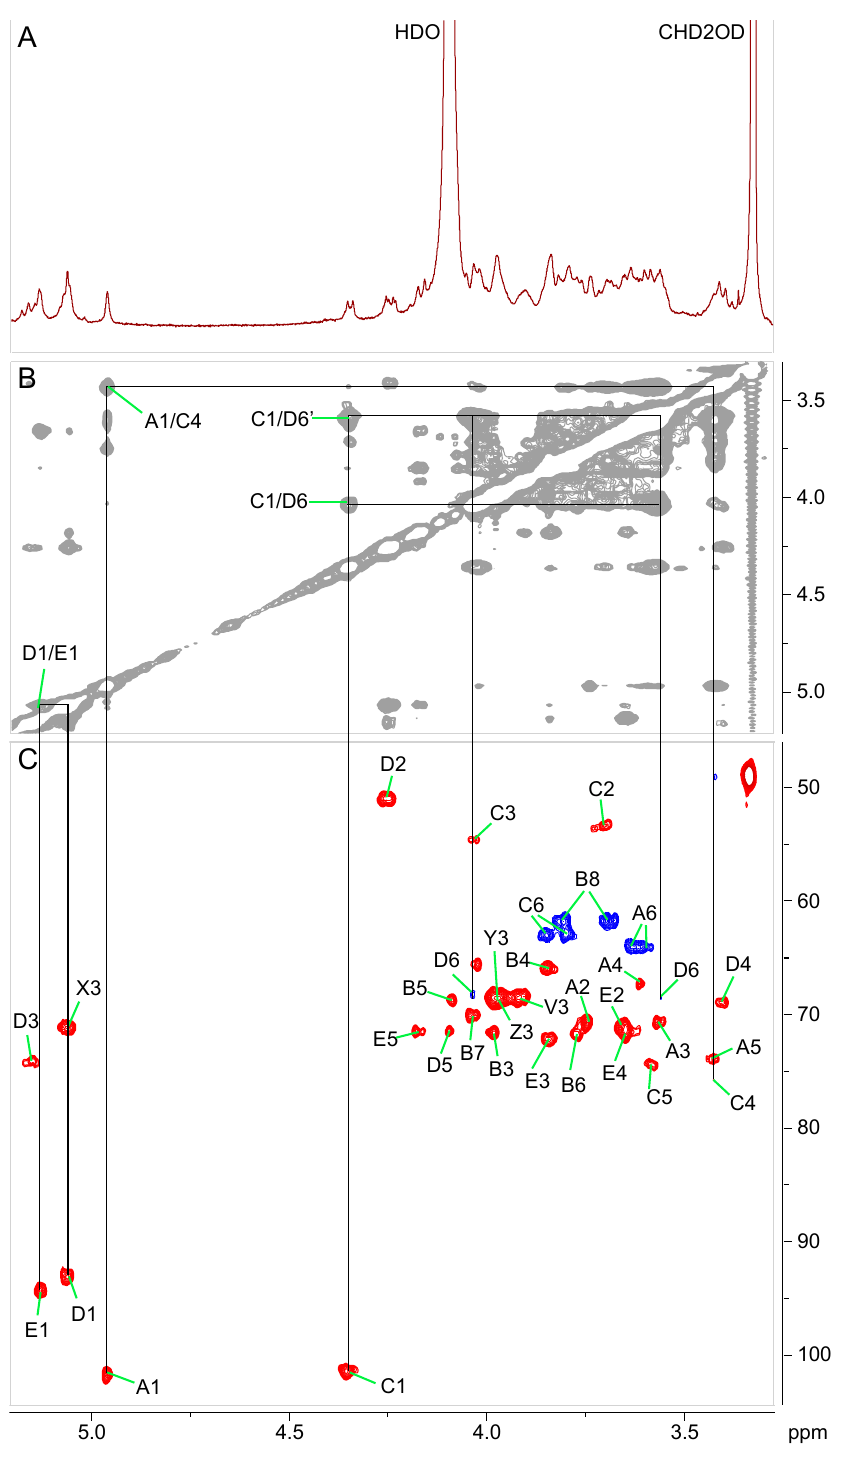
Figure 3. Partial 1 H ( A ), 1 H- 1 H nuclear Overhauser effect spectroscopy (NOESY) ( B ), and 1 H- 13 C- heteronuclear single-quantum correlation spectroscopy (HSQC) ( C ) NMR spectra of G. bethesdensis Ko–lipid A in 3:1 CDCl 3 –CD 3 OD solution. The spectra show the region containing mostly carbohydrate signals. The labels are explained in Tables 1 and 2.